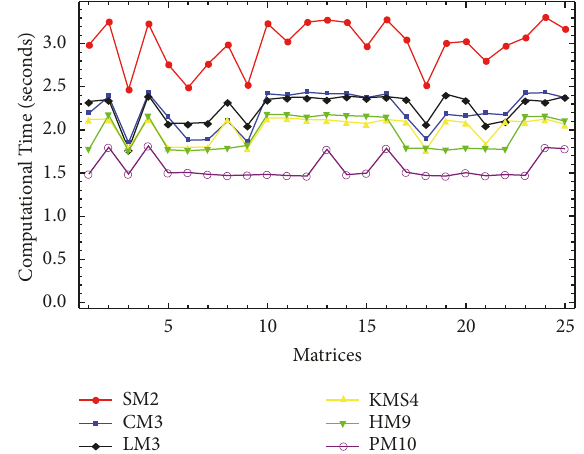
Figure 3: Comparison of the elapsed times for various methods in Experiment 3 for larger sizes 𝐴 10000×10000 and a different initial